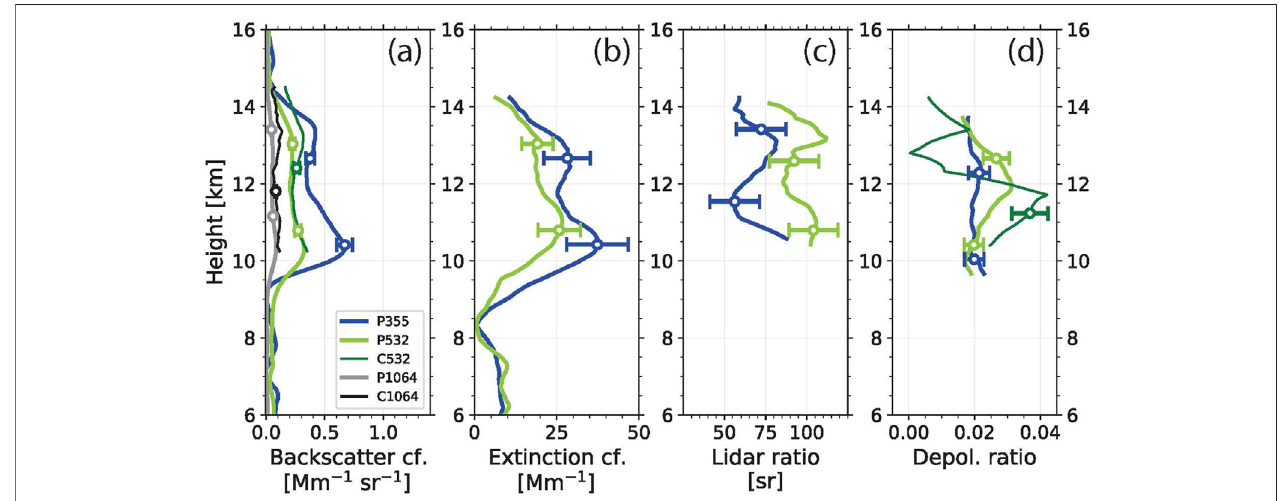
FIGURE 8 | Optical properties of stratospheric wild fi re smoke measured with the dual-wavelength Raman lidar Polly at Leipzig on August 14, 2019, 00:00 – 01:20 UTC.80-minmeanheightpro fi lesof (A) theparticlebackscatter coef fi cientatthreewavelengths, (B) theparticleextinctioncoef fi cientat355and532 nm, (C) respective lidar ratios, and (D) of the particle linear depolarization ratio at 355 and 532 nm are shown. Vertical signal smoothing lengths of 450 m (backscatter, depolarization ratio) and 1800 – 2000 m (extinction, lidar ratio) are applied. Error bars (one standard deviation) indicate the estimated uncertainties. For comparison, mean particle backscattercoef fi cients(ina,C1064,C532,thinlines)andmeanparticledepolarizationratio(ind,darkgreen,thinline)measuredwithCALIOPinthelatitudinalbandfrom 50 to 58 ° N ( Figure 5 ) are shown in addition.